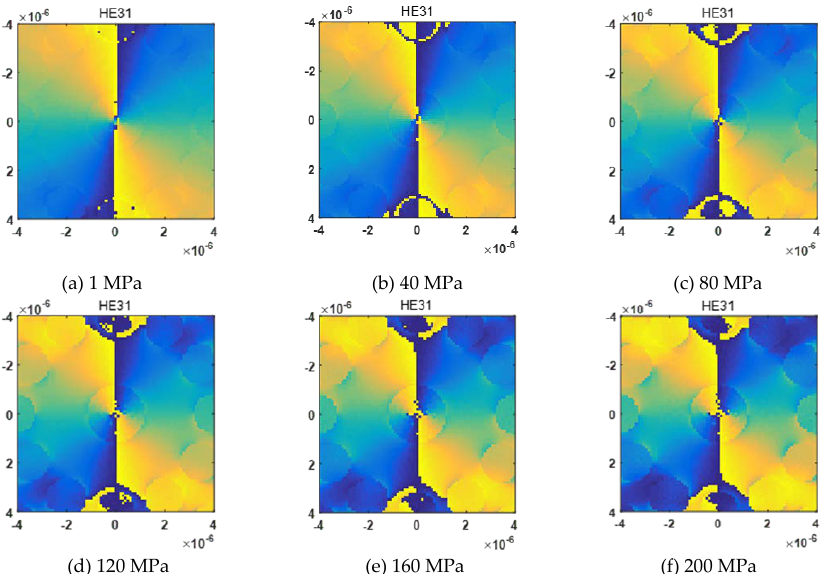
Figure 9. The intensity distribution of the axis cross-section in even and odd modes of HE31 under 1–200 MPa stress in the y direction.